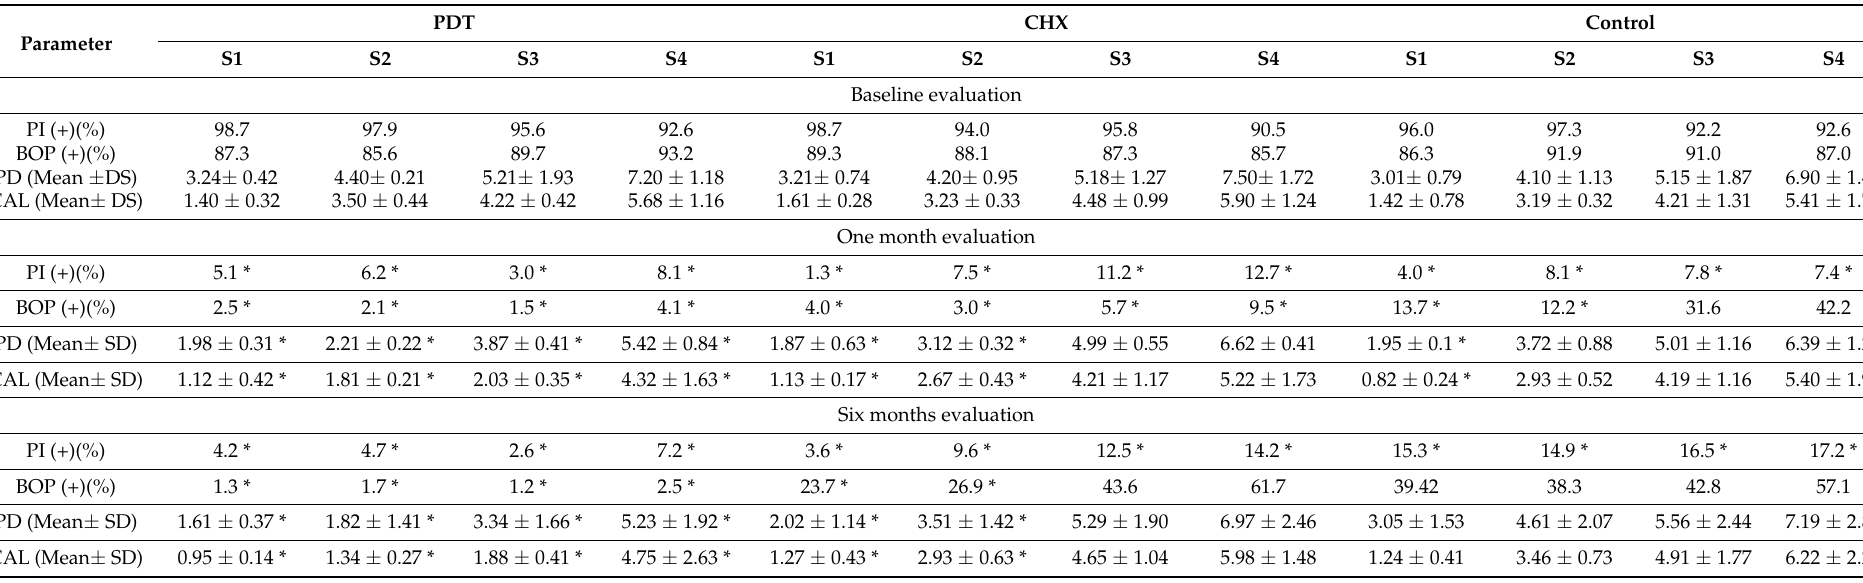
Table 3. Periodontal parameters on study groups and periodontitis severity at baseline, one month and six months